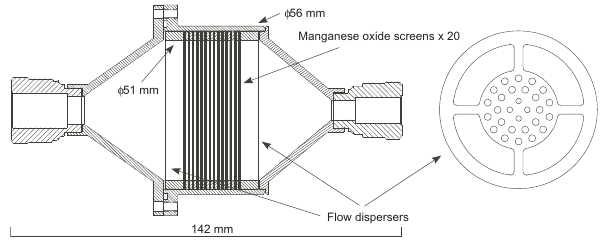
Fig. 4. Cross-sectional view of the catalytic O 3 scrubber (left) and flow disperser (right). The exposed manganese oxide screen diame- ter is 51mm. The schematic is shown to